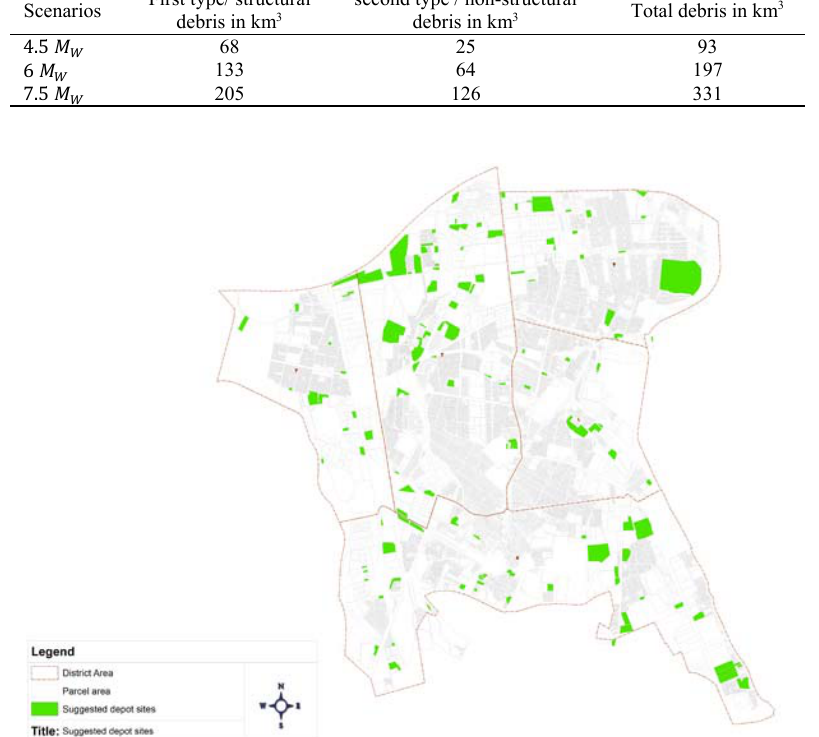
Fig. 1: Distribution of depot locations for the debris in Ray